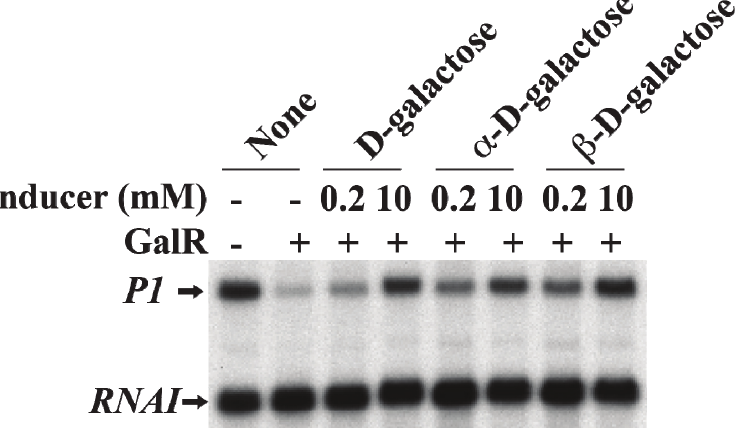
Figure 17. Derepression of P1 by D -galactose. mRNAs made from P1 in the presence of GalR (80 nM) and D -galactose, (cid:3)- D -galactose or (cid:7)- D -galactose 0.2 and 10 nM) (adapted from